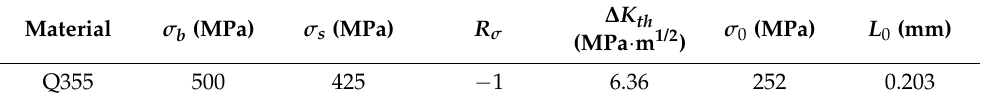
Table 2. Basic parameters of